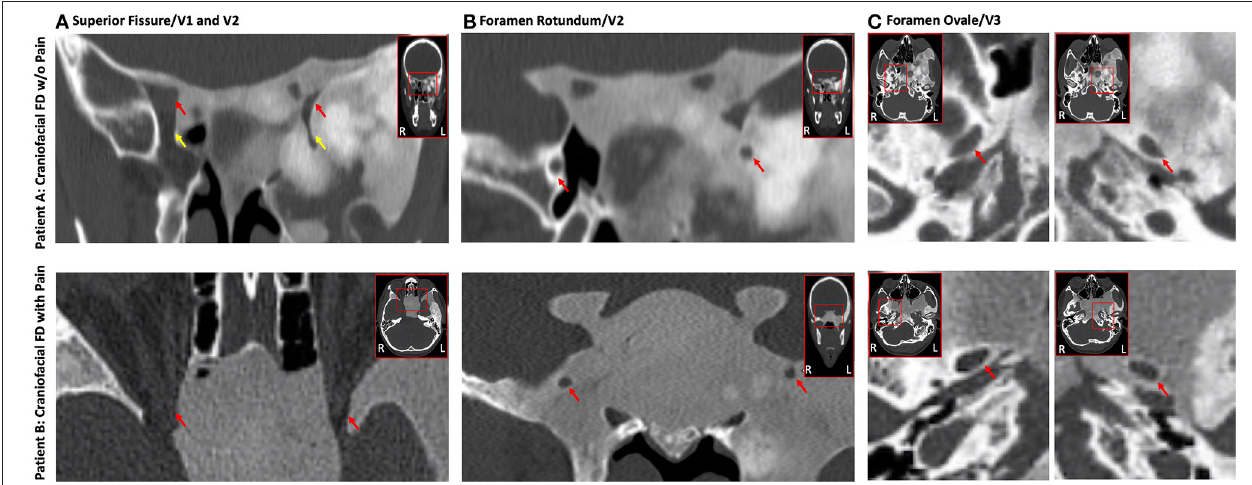
FIGURE 3 | Impact of FD on the trigeminal nerve system. Craniofacial FD lesions caused a highly similar impact on conduits carrying trigeminal nerves in both Patients A and B. Displacement and narrowing of the V1 (A) , V2 (B) , and V3 (C) divisions of the trigeminal nerves was evident on CT for both FD patients with generally a greater impact on left hemisphere structures relative to the right. The top (Patient A) and bottom (Patient B) rows show coronal or axial cross-sections from CT. (A) Constriction of the superior orbital fissure (red arrow) and inferior orbital fissure (yellow arrow; Patient A only). (B) Narrowing and displacement of the left foramen rotundum (red arrows). (C) Narrowing and displacement of the left foramen ovale (red arrows). (C) All data were read by a board-certified neuroradiologist (Dr. Romo).